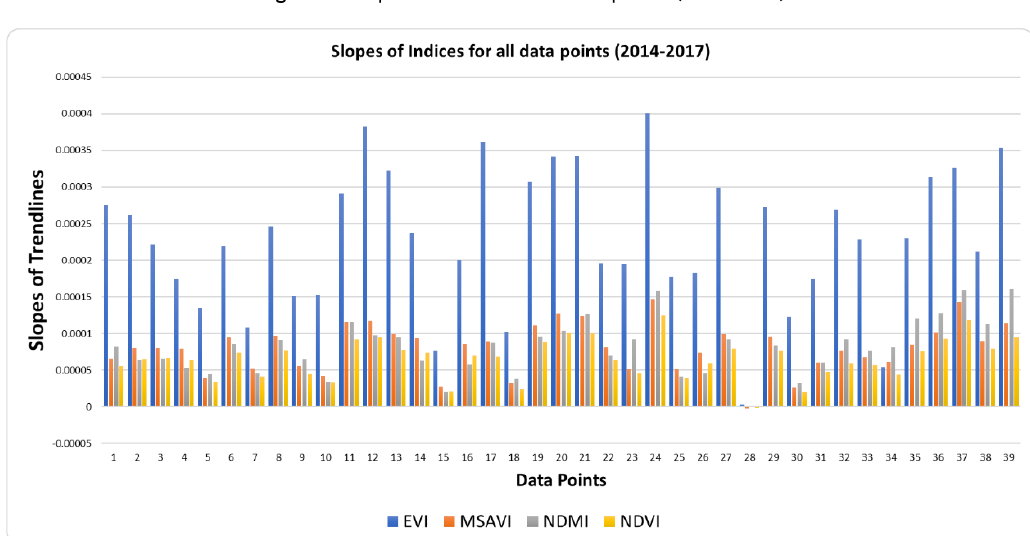
Figure 3 : Slopes of Indices for all data points (2013-2014)